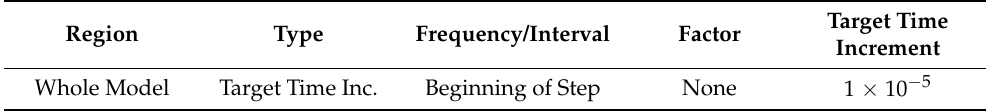
Table 9. Quasi-static mass scaling